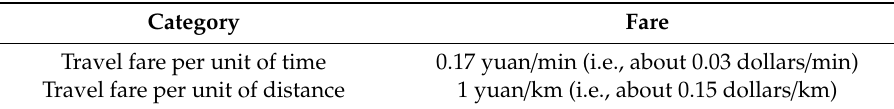
Table 3. Charge standard of car sharing in